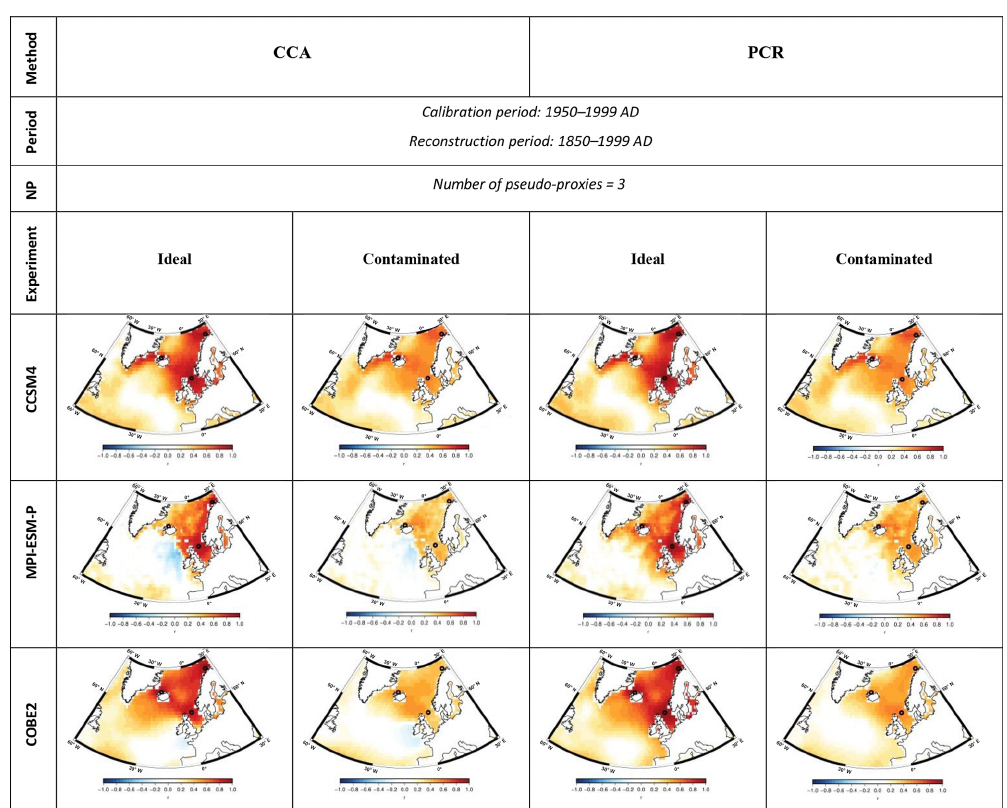
Figure 5. Correlation coefficient between the reconstructed and the original SST anomaly evolution of the NA field during the industrial era for the ideal (first and third column) and the noise-contaminated experiment (second and fourth column) when the number of proxy locations used is NP = 3. The results are given for the recent calibration period (1950—1999 AD) for two different reconstruction methods (first and second column CCA, third and fourth column PCR), the models CCSM4 (first row) and MPI-ESM-P r1 (second row), and the reanalysis data COBE2 (third